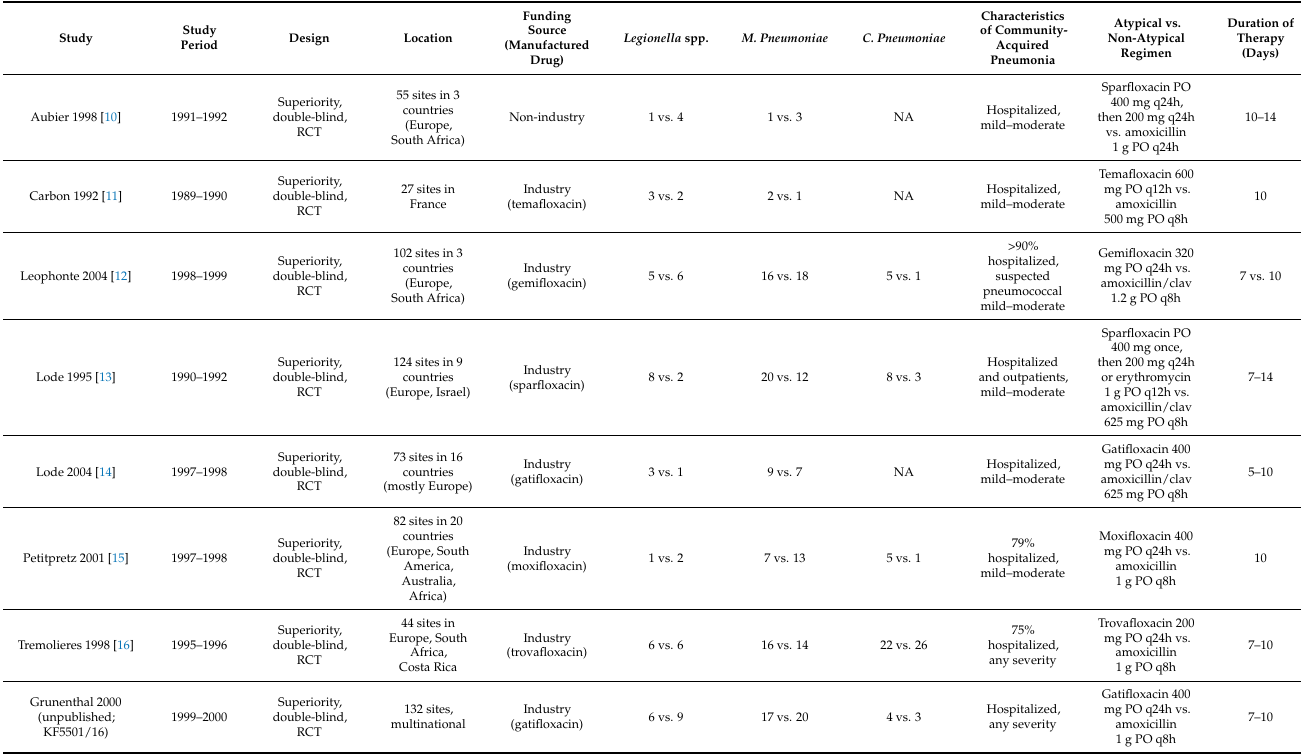
Figure 1. Flow diagram of the study selection process. Table 1. Characteristics of the included studies.